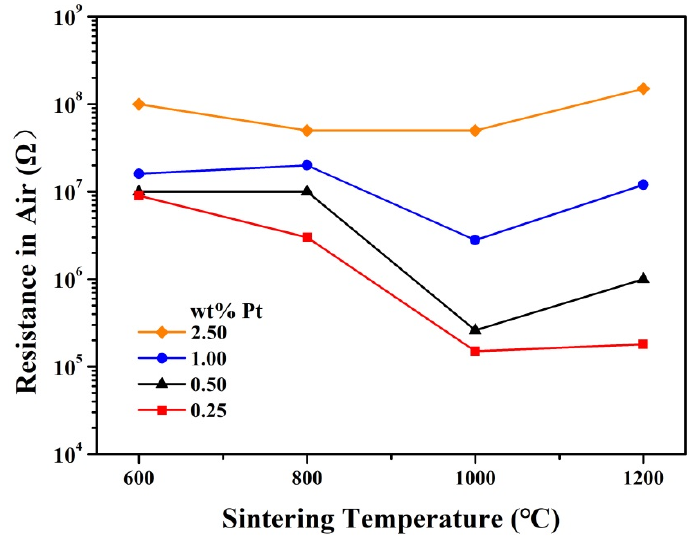
Figure 6. Evolution of resistance in air with sintering temperature for Pt-SnO 2 nanoceramics of various Pt contents.